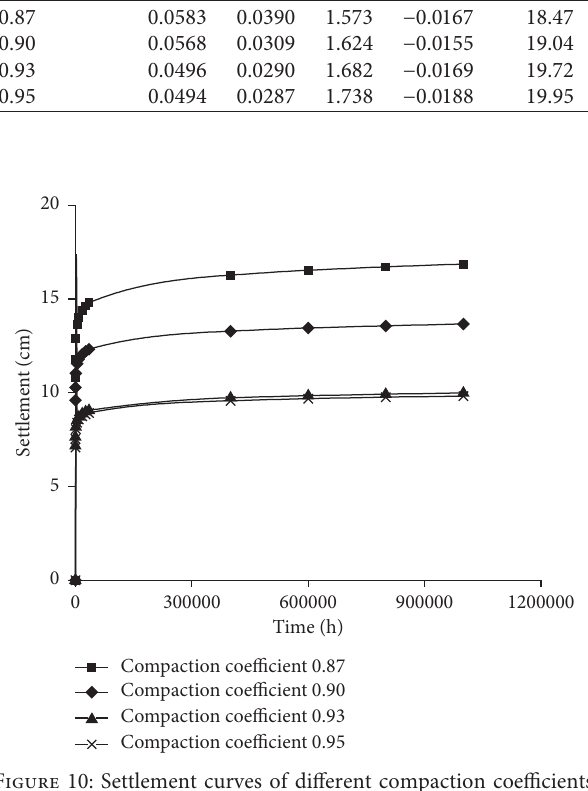
Figure 10: Settlement curves of different compaction coefficients with 10 m filling thickness.